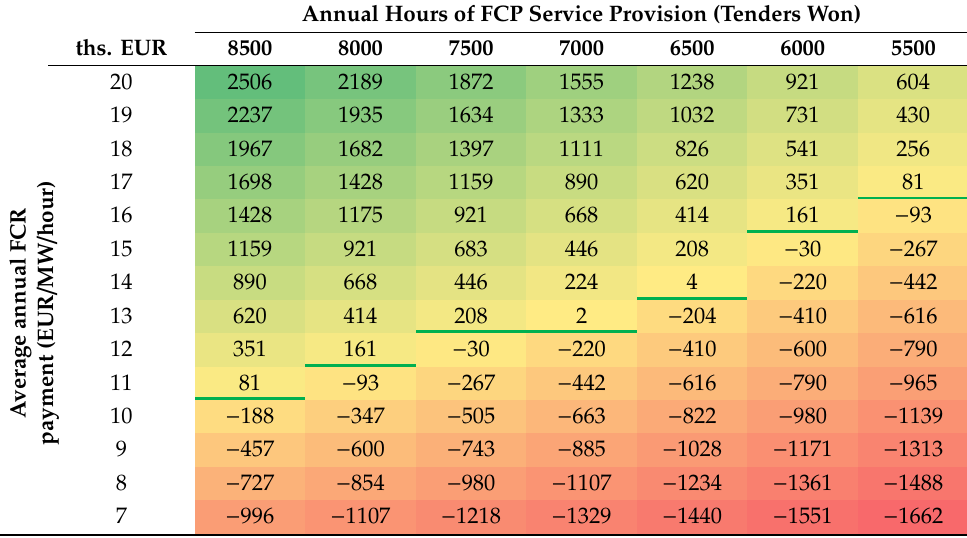
Table 12. Sensitivity analysis of the annual hour tenders won and average annual FCR payments. Annual Hours of FCP Service Provision (Tenders